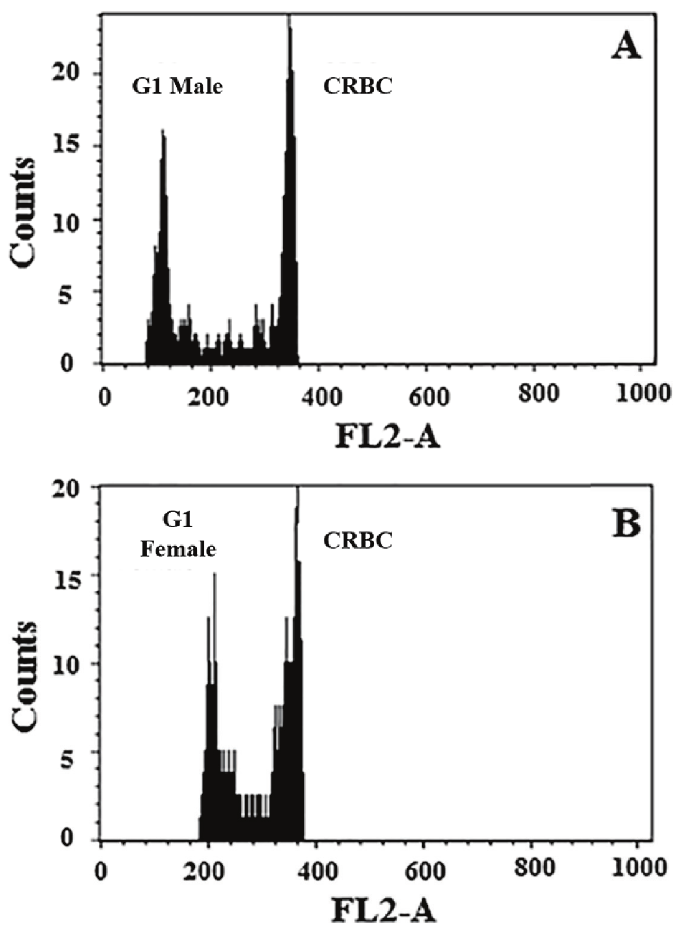
Figure 2. Flow cytometric estimation of the nuclear DNA content of haploid male and diploid female B. tabaci MEAM1. Histograms represent relative fluorescence of stained nuclei of male ( A ) and female ( B ) whiteflies relative to the internal standard, chicken red blood cells (CRBC). X-axis = relative nuclear DNA content; Y-axis = number of